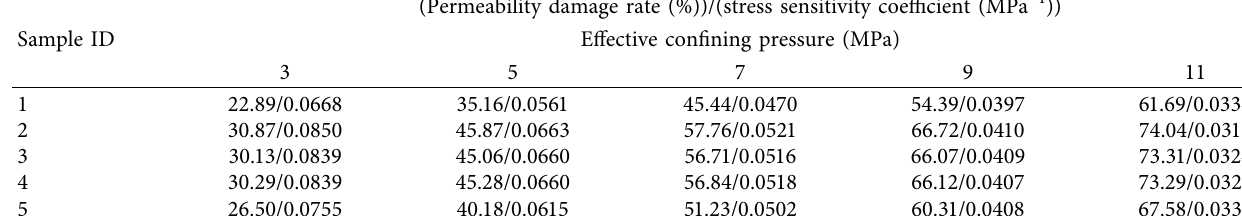
Table 3: Permeability damage rates and stress sensitivity coefficients for samples at different effective stresses. Sample ID